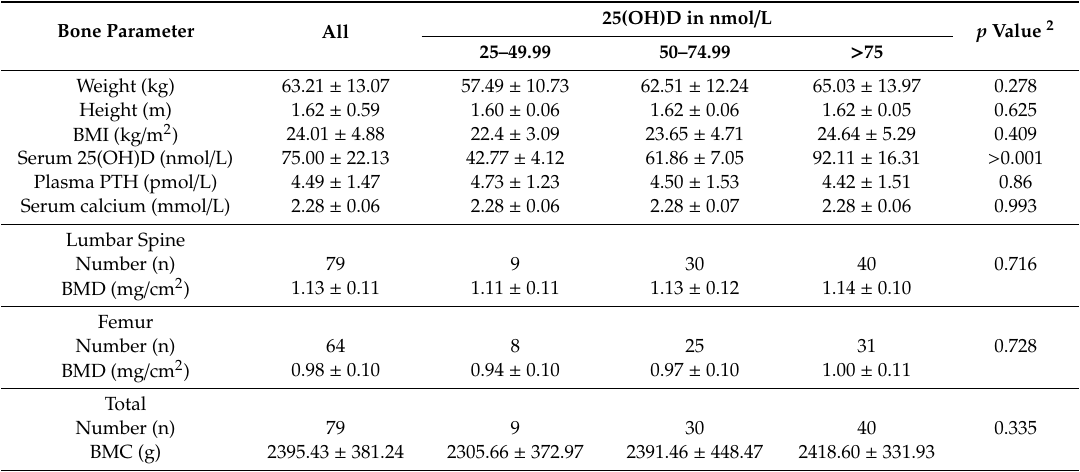
Table 7. Lumbar spine and femur bone densitometry assessed by DXA of Brazilian women living in Brazil by vitamin D status ( n = 79) 1